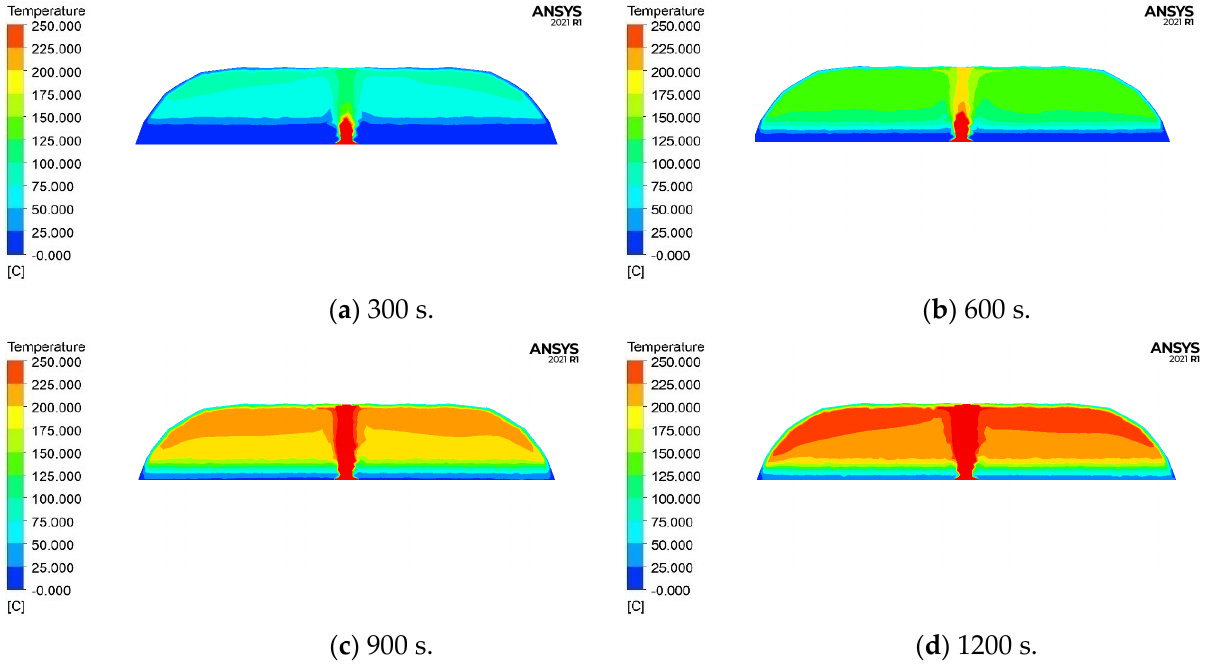
Figure 4. Temperature of the structure in the very-fast-grow fire event.